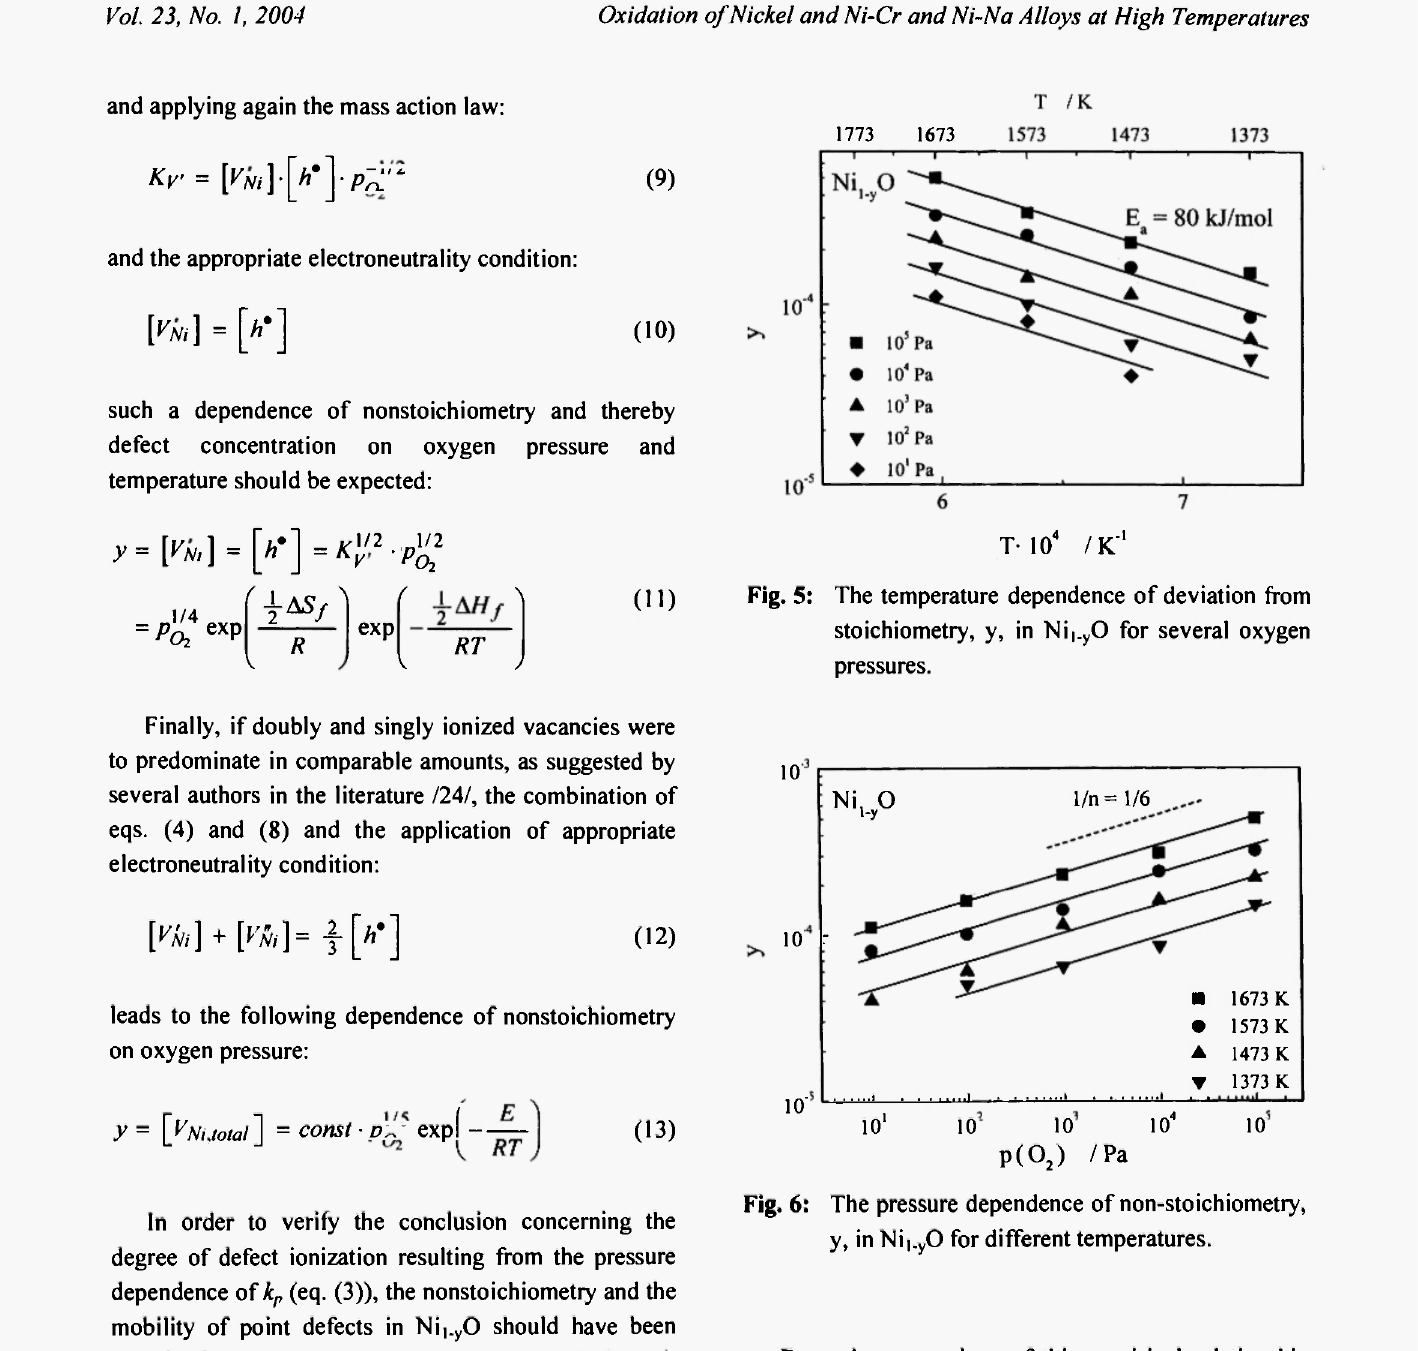
From the comparison of this empirical relationship with theoretical eq.(7), the enthalpy and entropy of the formation of double ionized cation vacancies in Ni,. y O could be calculated: Δ / // = 240 kJ/mol, Δ 5 /= - 35.3